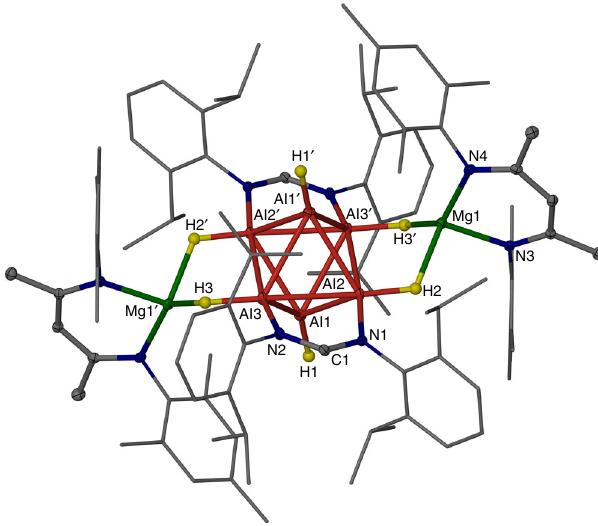
Fig. 2 Molecular structure of 1a . Hydrogen atoms, except hydrides, omitted. Ellipsoids shown at the 20% probability level, except aryl substituents, which are shown as wire frame. Selected bond lengths (Å): Al(1) –